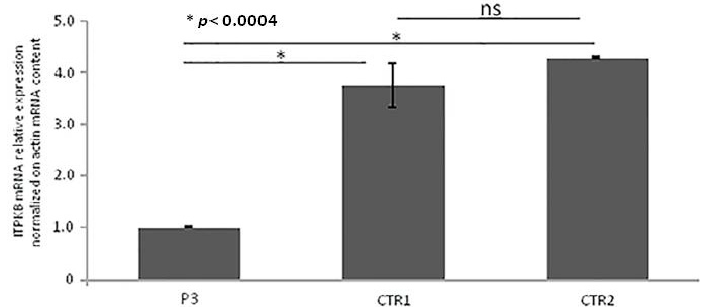
Figure 6. Real-time qRT-PCR of ITPKB gene mRNA expression. Quantitative RT-PCR was performed using two specific couples of primers. ITPKB mRNA expression was normalized on Actin mRNA content. The error bars represent technical replicates within a single experiment. Each experiment has been repeated three times. Statistical analysis was performed by comparison between controls and affected ITPKB mRNA content. * p < 0.0004 and ns = not statistically significant.